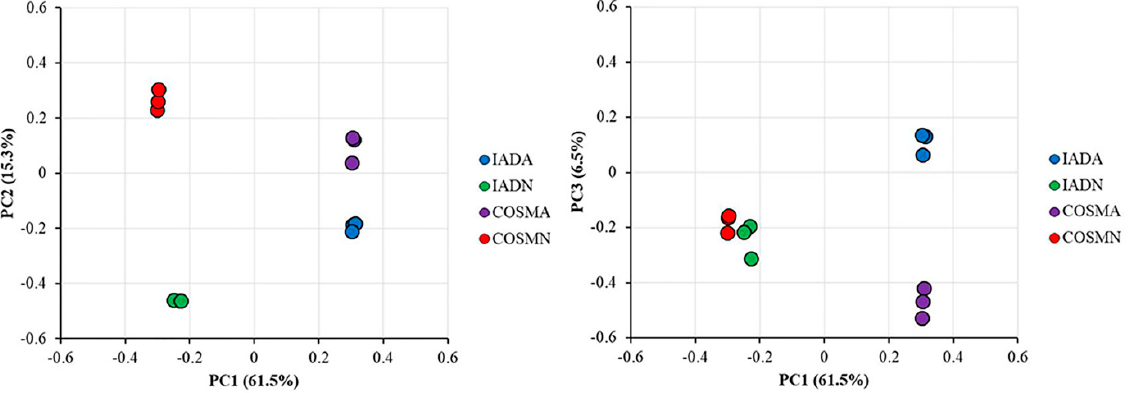
Figure 3. PCA of iTRAQ results in each treatment of food and developmental stage. Percentages indicate total variance explained by the first, second and third PC. The three biological replicates of a treatment are shown by dots of the same color.